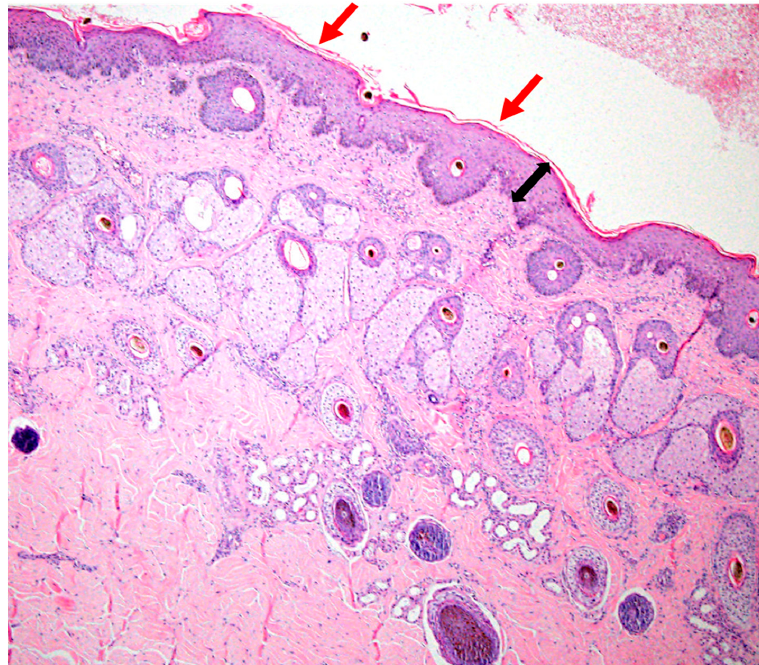
Figure 6. Skin histopathology from a horse with severe dermatitis, showing mild lymphocytic, hyperplastic dermatitis (H.E. 40× objective). Black arrows highlight perivascular inflammatory cells; yellow arrows highlight plump endothelial cells of dermal capillaries; red arrows highlight leucocytes in epithelium.